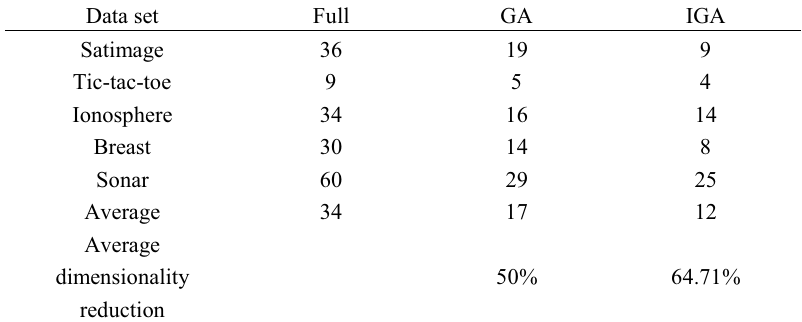
Table 3 Number of features selected by GA and IGA on different data sets